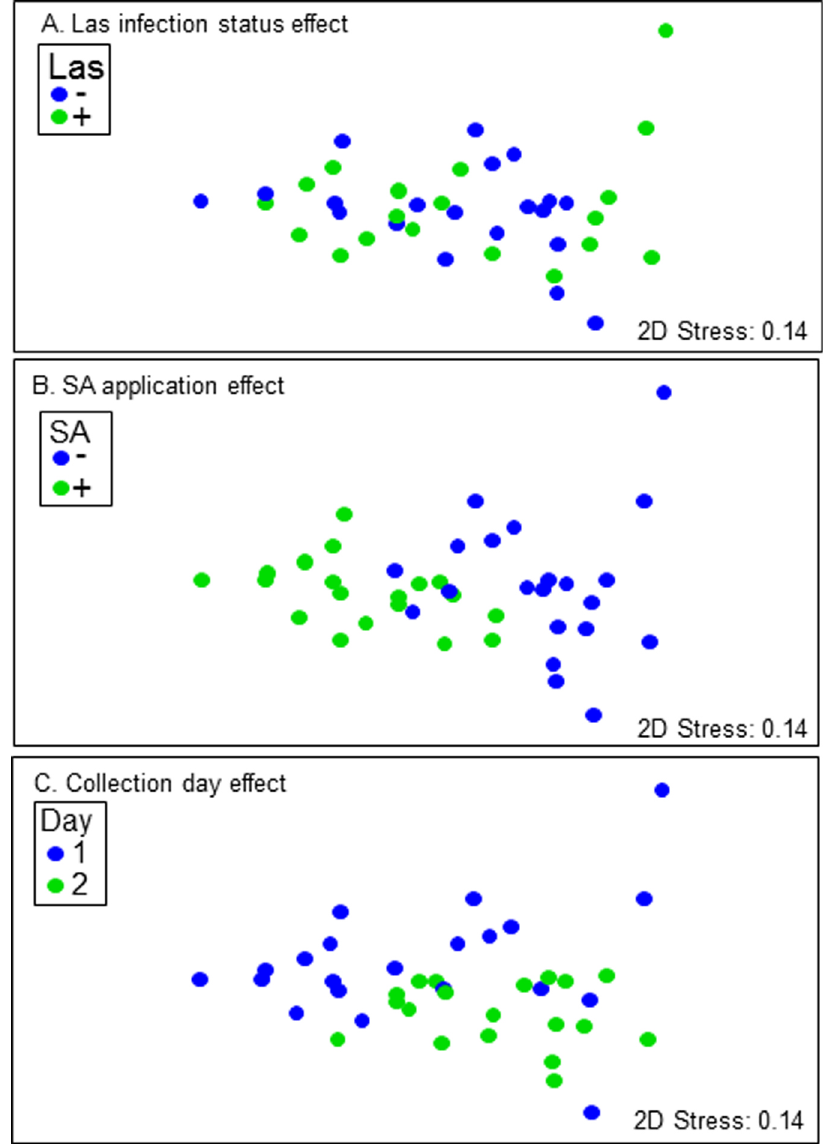
Fig 3. Nonmetric multidimensional scaling (NMDS) of the main effects on proportions of emitted volatile compounds in the SA experiments. NMDS plots showing the effects of (A) Las infection status, (B) SA application, (C) collection day on the proportions of volatiles emitted. Comparisons of the proportions of volatile compounds in each treatment were based on Bray-Curtis similarities plotted in a non-metric multidimensional scaling.